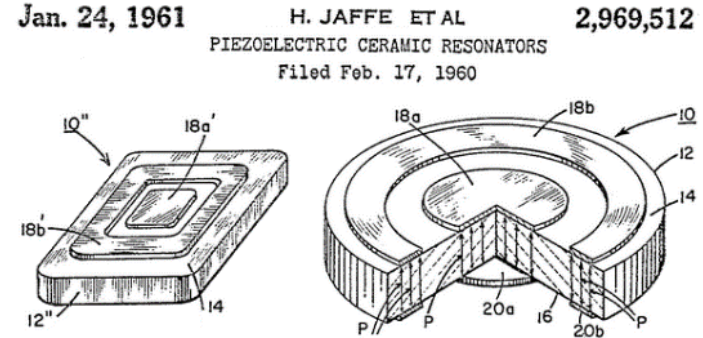
Figure 5. Unipoled piezoelectric transformers by Jaffe and Berlincourt [27].